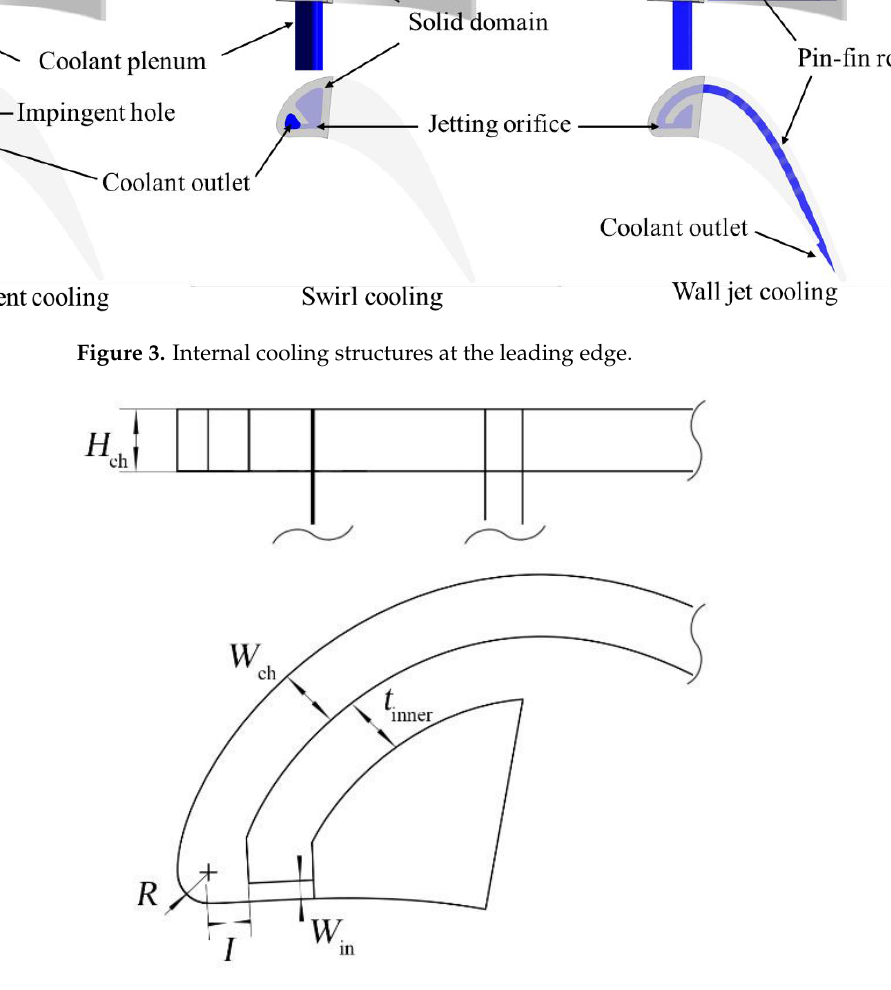
Figure 3. Internal cooling structures at the leading edge.